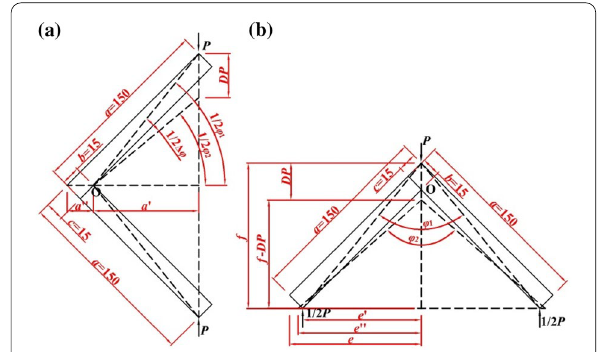
Fig. 4 Method of joint analysis: a compression, b